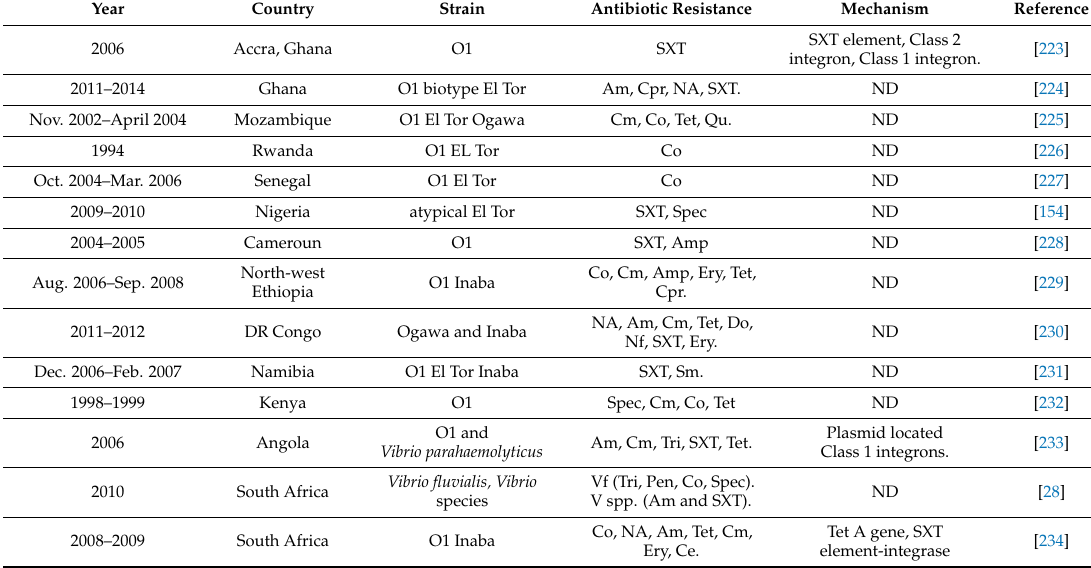
Table 5. Selected drug-resistant Vibrio species strains reported in Sub-Saharan Africa. Adapted from [209] with slight modification. Year Country Strain Antibiotic Resistance Mechanism